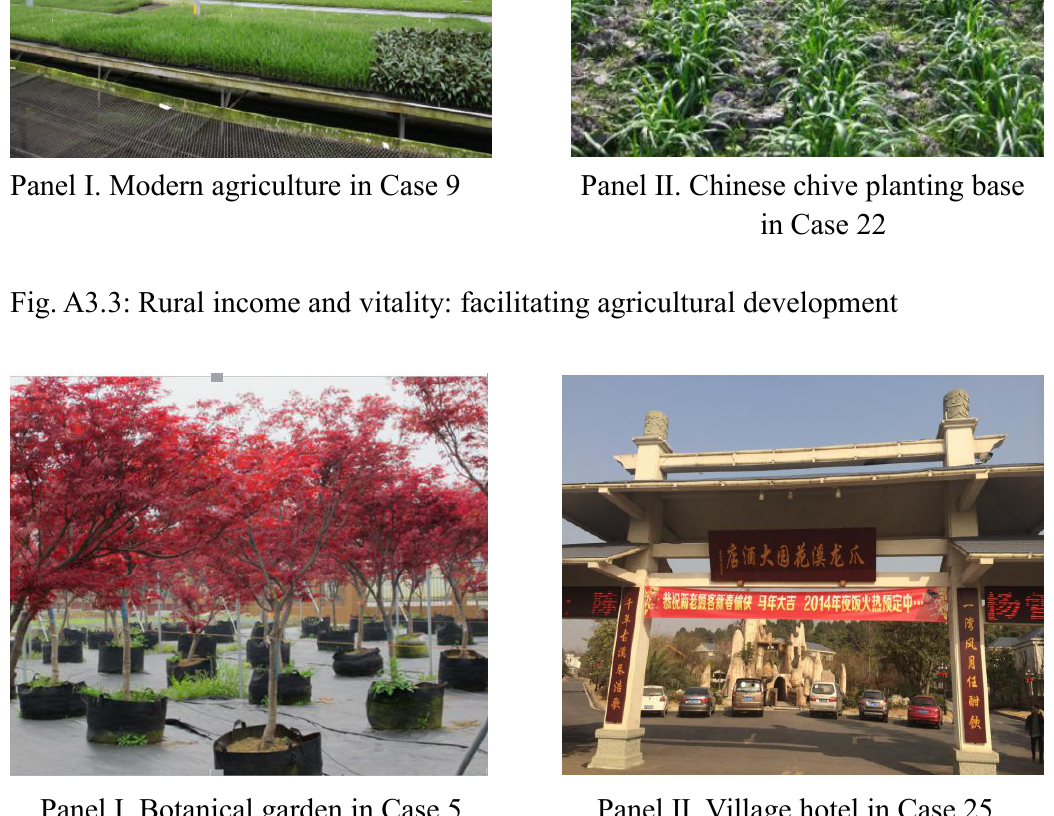
Panel Ⅰ. Botanical garden in Case 5 Fig. A3.4: Rural income and vitality: facilitating rural